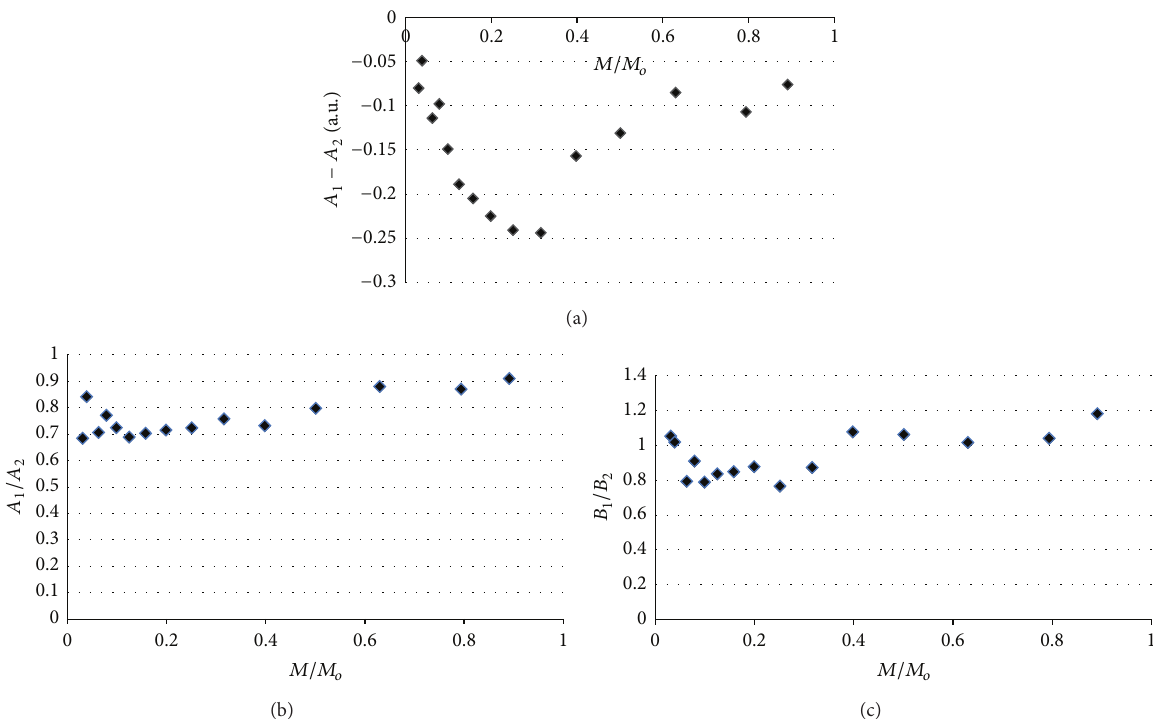
Figure 9: The effect of microwave power on the line shape parameters: (a) 𝐴 1 −𝐴 2 , (b) 𝐴 1 /𝐴 2 , and (c) 𝐵 1 /𝐵 2 , for the EPR spectra of bismuth subgallate thermally sterilized at 180 ∘ C (30 minutes). 𝑀 —microwave power used during the measurement of the EPR spectra, 𝑀 𝑜 —total microwave power produced by klystron (70 mW).